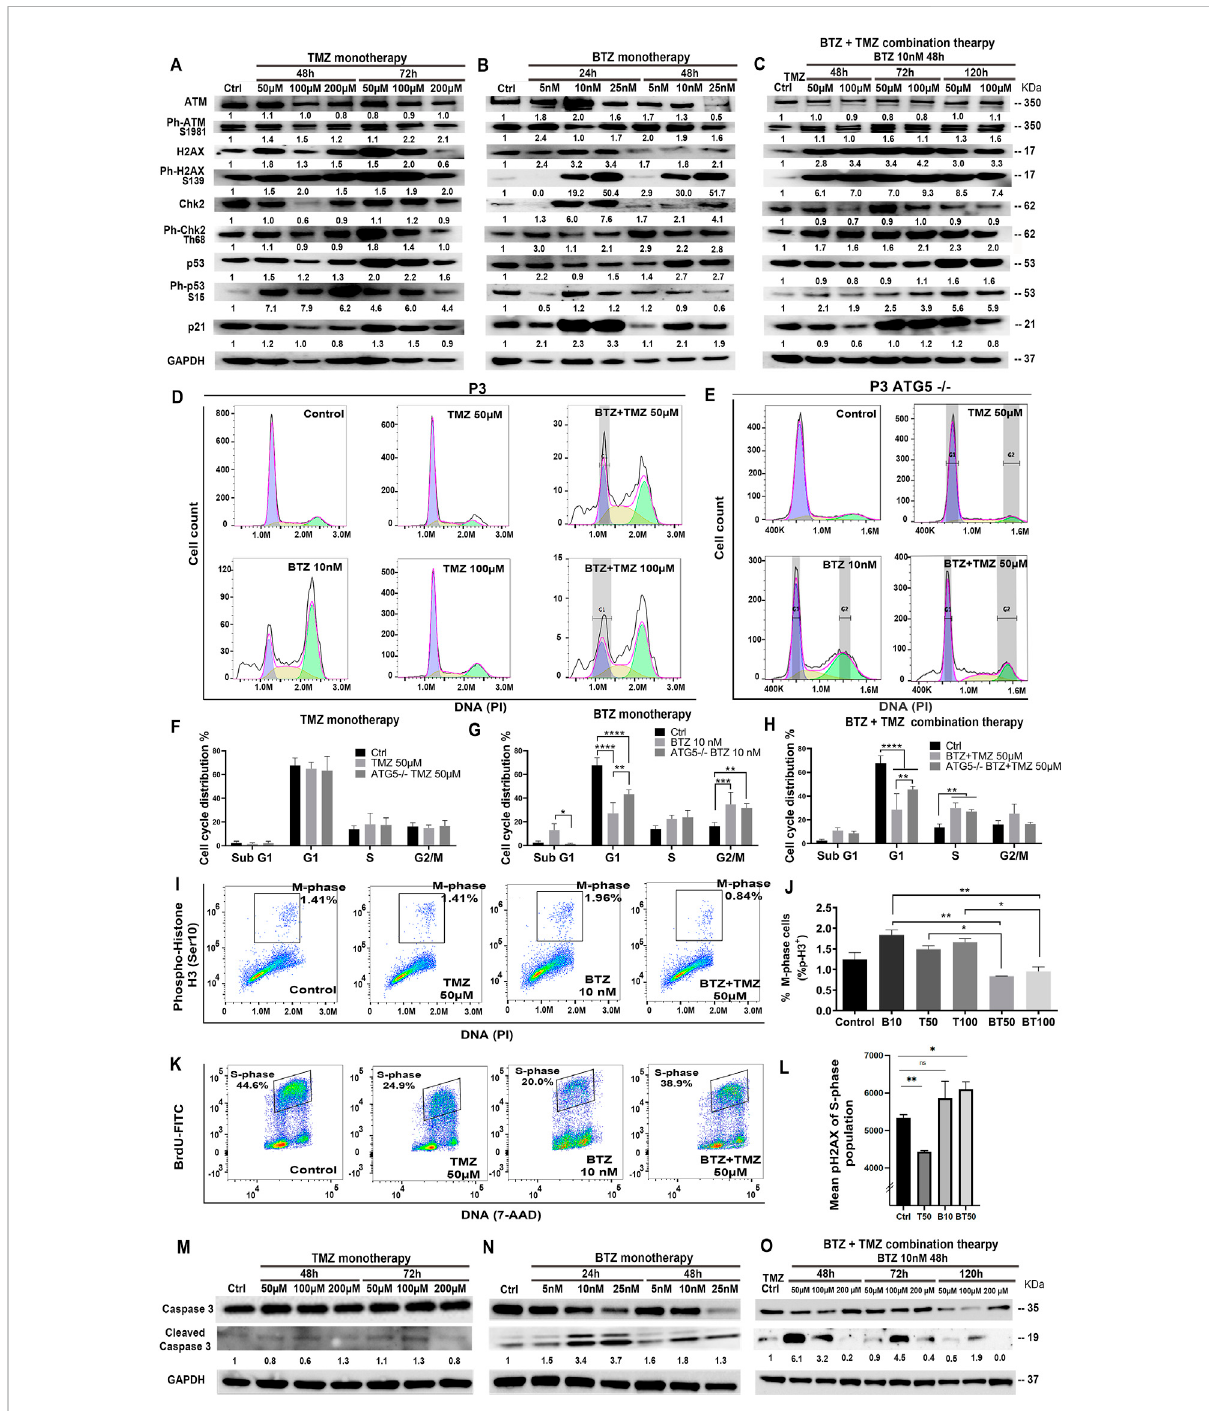
FIGURE 6 BTZ pre-treatment induces DNA damage signalling and G2/M phase cell cycle arrest in TMZ treated patient derived GBM cells. Proteins in DNA damage signalling cascade including total and phospho-proteins from lysates (20 µg) from P3 GBM cells treated with (A) TMZ monotherapy, dose escalation at 48 and 72h, (B) BTZ monotherapy, dose escalation at 24 and 48h and (C) combination treatment with BTZ 10 nM 48h and TMZ at indicated times. (D,E) DNA histograms showing cell cycle distribution of propidium iodide (PI) stained control and ATG5 − / − P3 cells, before and after respective treatments. Quanti fi cation of cellular proportions (%) in respective cell cycle phases after (F) TMZ monotherapy, (G) BTZ monotherapy and (H) BTZ + TMZ therapy. (I) Dot plots ofP3 cells inM-phase (phospho-histoneH3 positive cells) after therespective treatments; (J) Quanti fi cation of experiments are shown in panel I, showing % of P3 cells in M-phase of the cell cycle as indicated. (K,L) Evaluation of treatment- induced DNA double-strand breaks (DSBs) by fl ow cytometry. Immuno fl uorescent staining of pH2AX and BrdU was performed as described